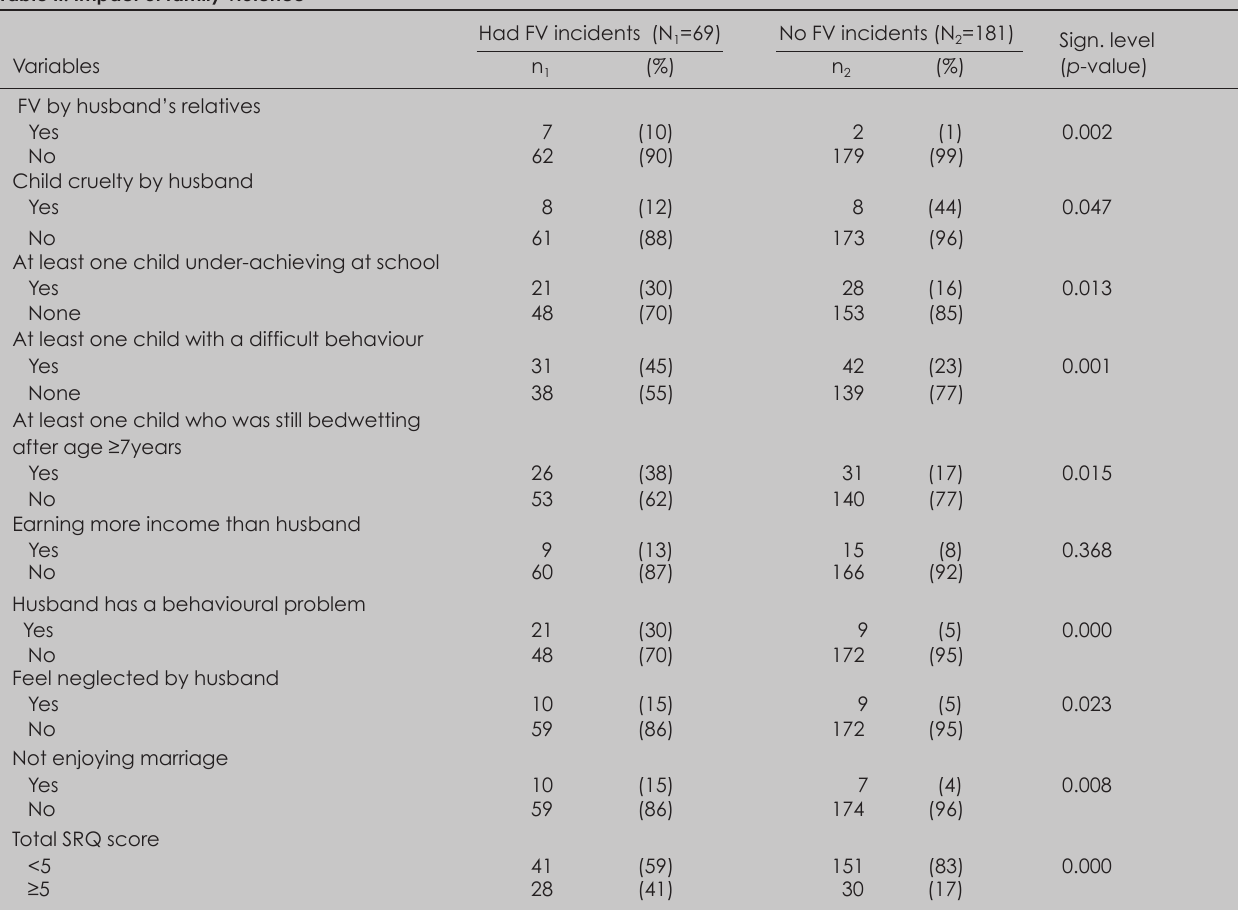
Table II. Impact of family violence